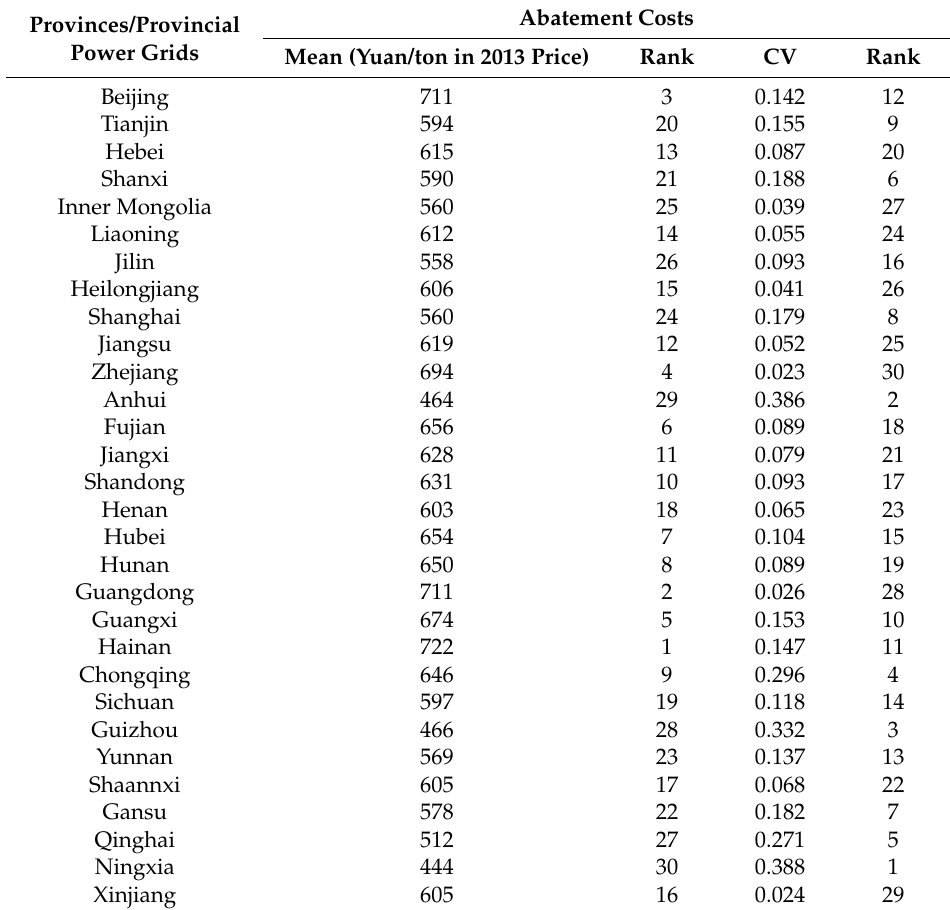
Table 7. Mean abatement costs for 30 provincial power grids,